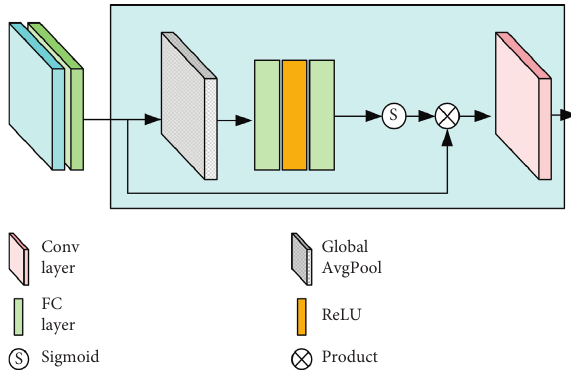
Figure 7: Fusion attention module